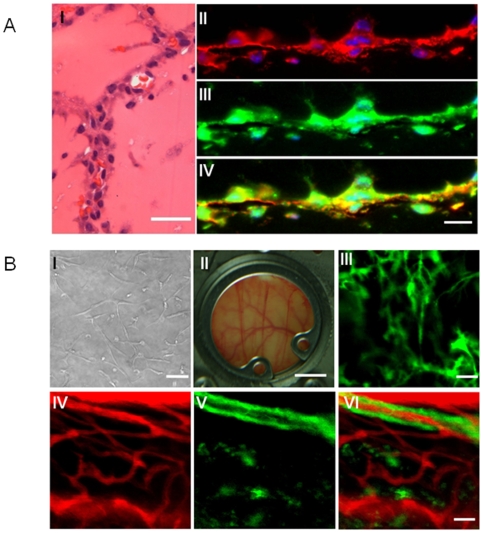
Demonstration of functional vessels in vivo using Matrigel plug and dorsal window chamber.(A) Matrigel plug with hESC-ECs were implanted subcutaneous injection in the dorsal region of 8-week-old SCID mice. (I) HE stain of Matrigel plug. Some of these microvessels have mouse blood cells in their lumen. (II–IV) 14-day Matrigel plugs were stained with anti-human CD31 (red) and anti-GFP (green) antibodies, showing microvessels that are immunoreactive with these human-specific antibodies. Scale bars = 20 µm. (B) Dorsal window chamber model in SCID mice. GFP+ hESC-ECs were cultured in a mix of collagen and Matrigel for 1 day (left, upper panel), and implanted into dorsal windows in SCID mice (middle, upper panel). Images were taken at day 2, 14 and 21 after implantation. After 14 days, Angiosense 680 was injected by tail vein to highlight perfused vessels within the dorsal window. Green, hESC-ECs expressing GFP; red, functional blood vessels with contrast enhanced by Angiosense 680. Scale bars = 20 mm (middle, upper panel), 20 µm (others).